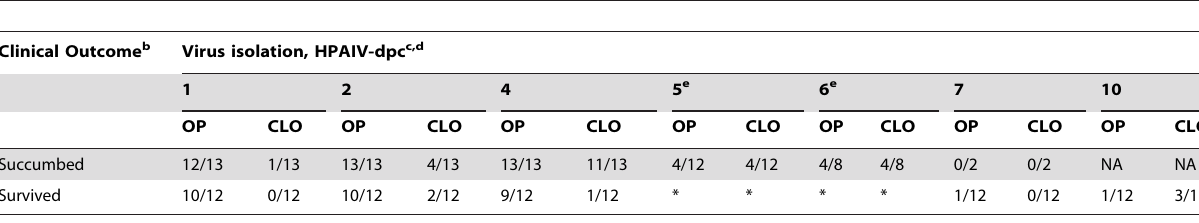
Table 3. Clinical outcome and virus isolation data of wood ducks ( Aix sponsa ) challenged a with the highly pathogenic avian influenza virus A/whooper swan/Mongolia/244/05